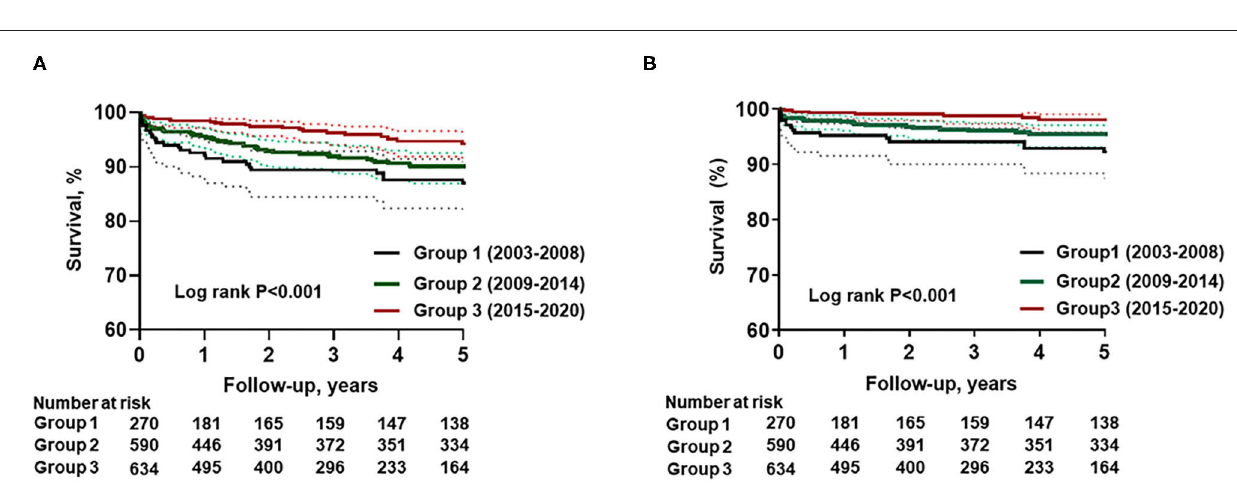
FIGURE 4 | Temporal trends in clinical outcomes: (A) survival from all-cause death, (B) survival from cardiovascular